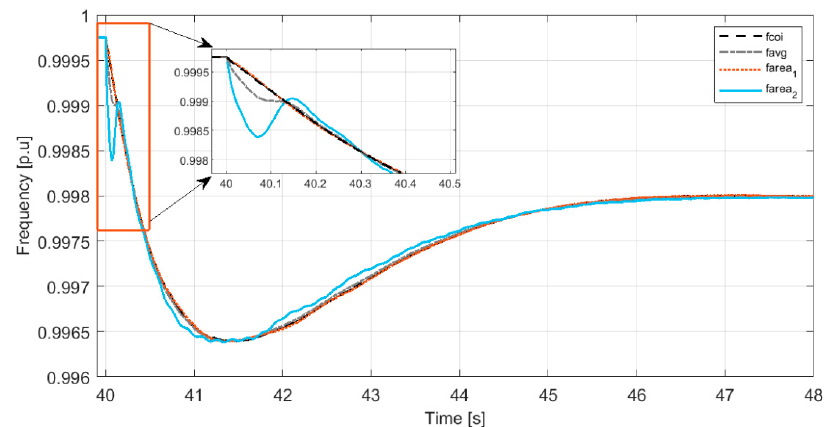
Figure 6 . Comparison of the system unweighted average frequency, COI frequency and the average frequency in different areas of the system following a load step at bus 36.